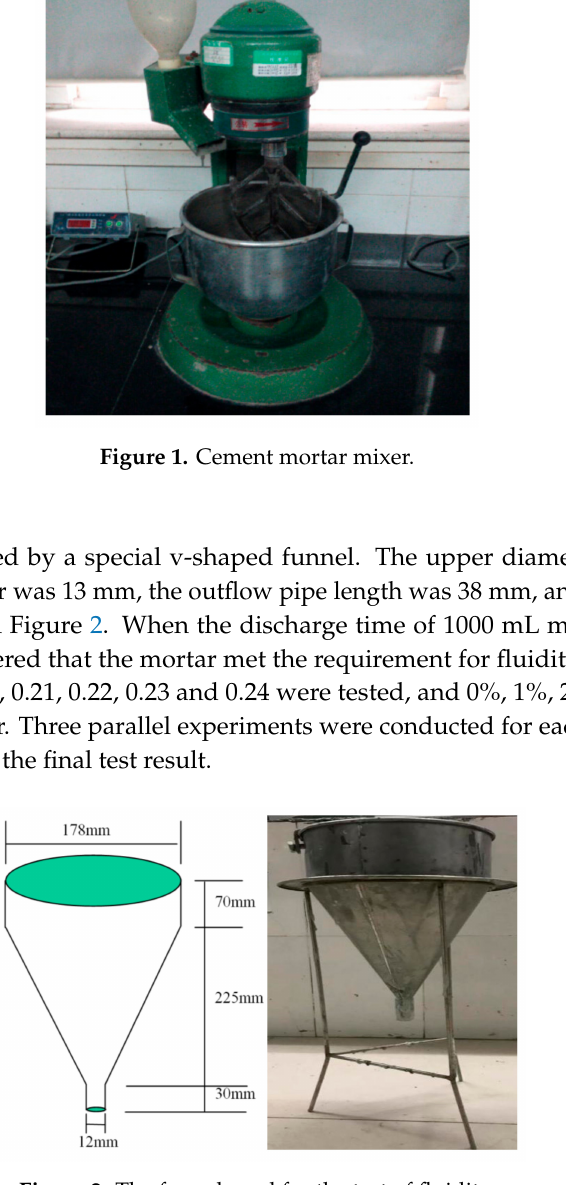
Figure 2. The funnel used for the test of